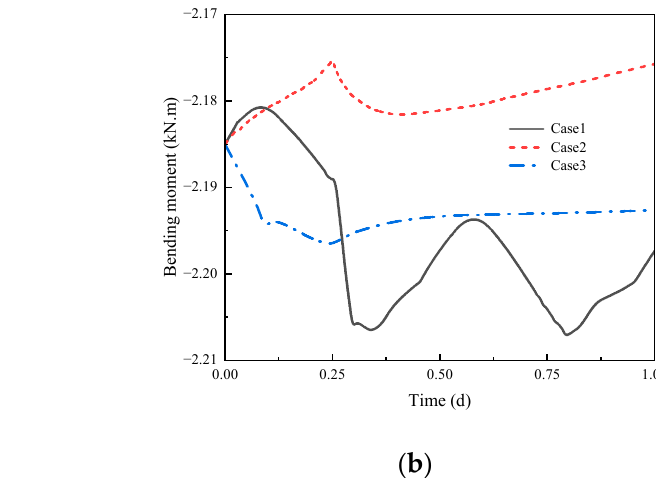
Figure 12. Time-history curves of maximum axial force and bending moment of the No. 1 pile under three cases: ( a ) Time-history curve of maximum axial force. ( b ) Time-history curve of maximum bending moment.